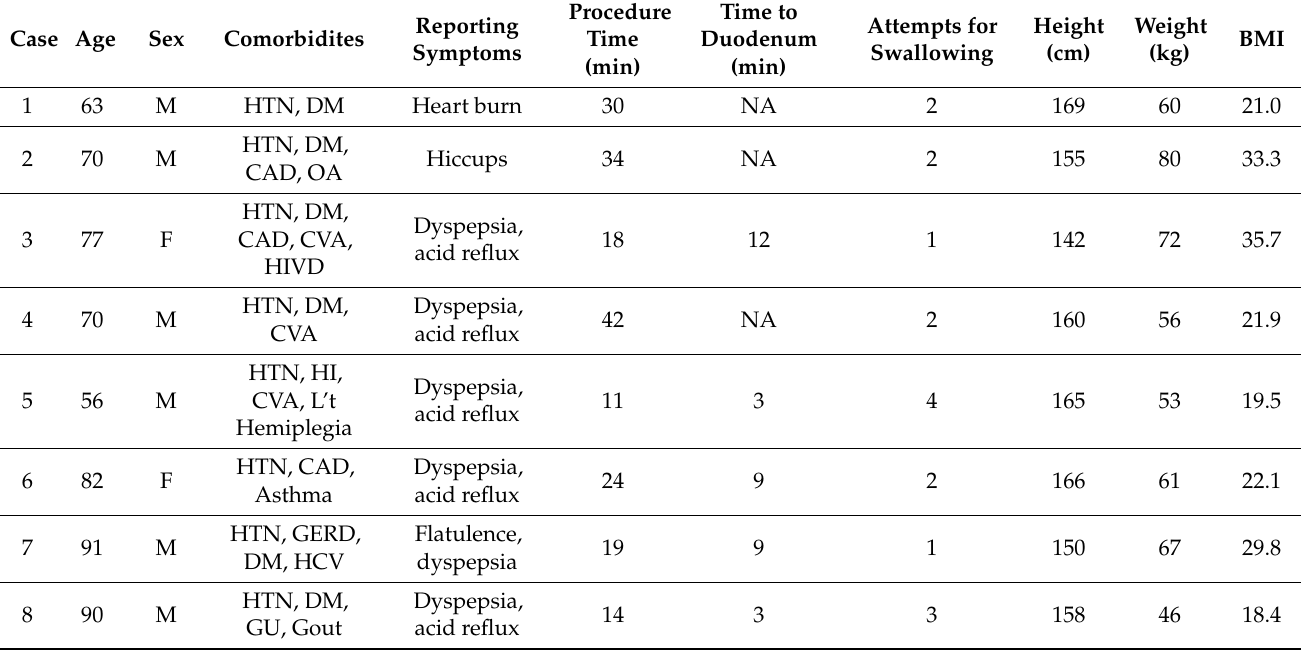
Table 1. Demographic characteristics of the patients. HTN: hypertension, DM: diabetes mellitus, CAD: coronary artery disease, OA: osteoarthritis, CVA: cerebrovascular accident, HIVD: herniated intervertebral disc, GEGRD: gastroesophageal reflux disease, HCV: hepatitis C virus, GU: gastric ulcer, CP: cerebral palsy, Pul TB: pulmonary tuberculosis, ICH: intracranial hemorrhage, BMI: body mass